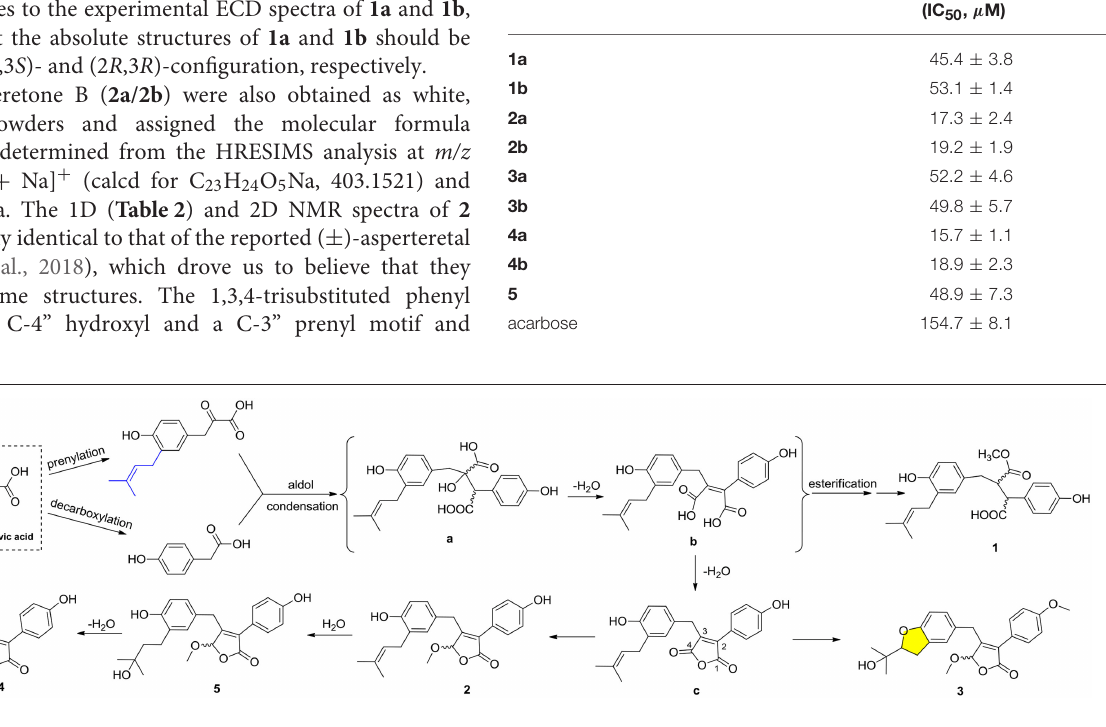
TABLE 3 | α -Glucosidase inhibitory activity of 1a/1b − 4a/4b and 5 .